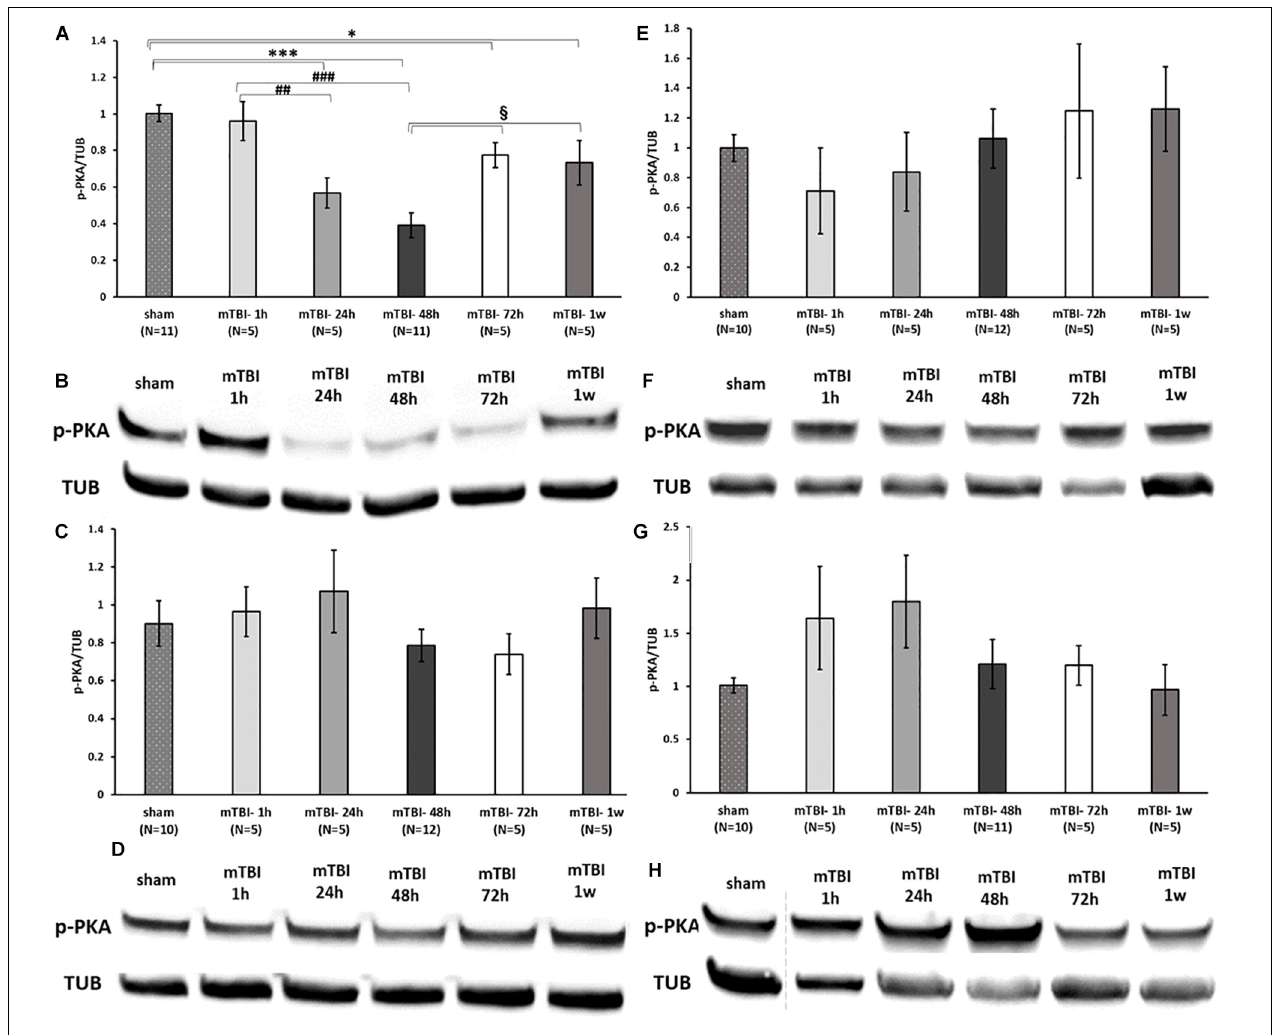
FIGURE 7 | mTBI results in a decline in p-PKA levels in ipsilateral cortex. Graphs presenting p-PKA expression in ipsilateral/right (A) and contralateral/left (C) cortex and ipsilateral (E) and contralateral (G) hippocampus in sham and 1 h to 1 week following mTBI. One-way ANOVA followed by Fisher’s LSD post hoc analysis revealed a significant reduction in p-PKA expression in cortex right 24 h to 1 week following mTBI [ A: F (5,36) = 12.060; p < 0.001, ∗∗∗ p < 0.001 sham vs. 24, 48 h and ∗ p < 0.05 sham vs. 72 h, 1 w], ## p < 0.01, ### p < 0.001 mTBI 1 h vs. mTBI 24 h and vs. 48 h, respectively, when the maximal reduction present in 48 h was followed by an elevation in the levels of PKA (72 h–1 week, §p < 0.05 vs. 48 h). Blots from all other regions remained unchanged by the injury [ C: F (5,36) = 0.809; NS, E: F (5,36) = 0.585; NS, G: F (5,35) = 1.373; NS]. Values are mean ± SEM. (B,D,F,H) Representative images of gel electrophoresis followed by immunoblot analysis using antibodies against p-PKA and α -tubulin in ipsilateral cortex, contralateral cortex, ipsilateral hippocampus, and contralateral hippocampus, respectively. A crop of the original image was performed in 7F at loading site number 2 of the gel due to an abnormal value of a control sample that was therefore excluded from the statistical